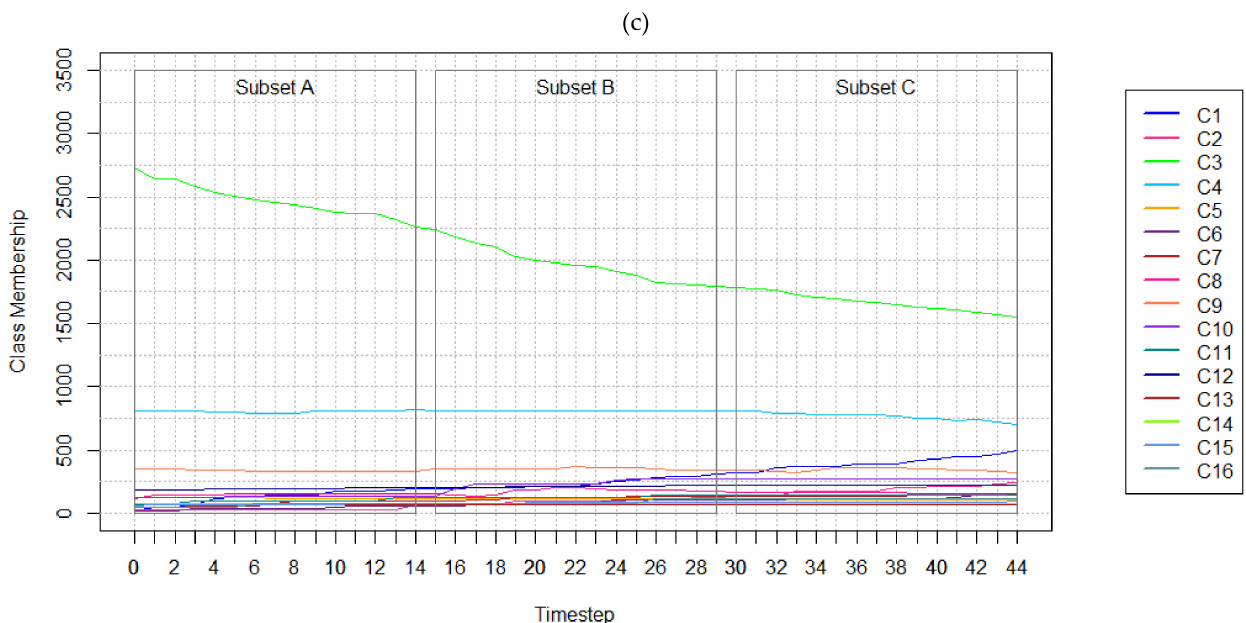
Figure 2. Number of cells belonging to each class at each timestep in the ( a ) 4 class, ( b ) 8 class, and ( c ) 16 class hypothetical LC datasets. Class membership” shows how many cells belong to each class at each timestep. Each dataset has identical dimensions, temporal resolution, and number of